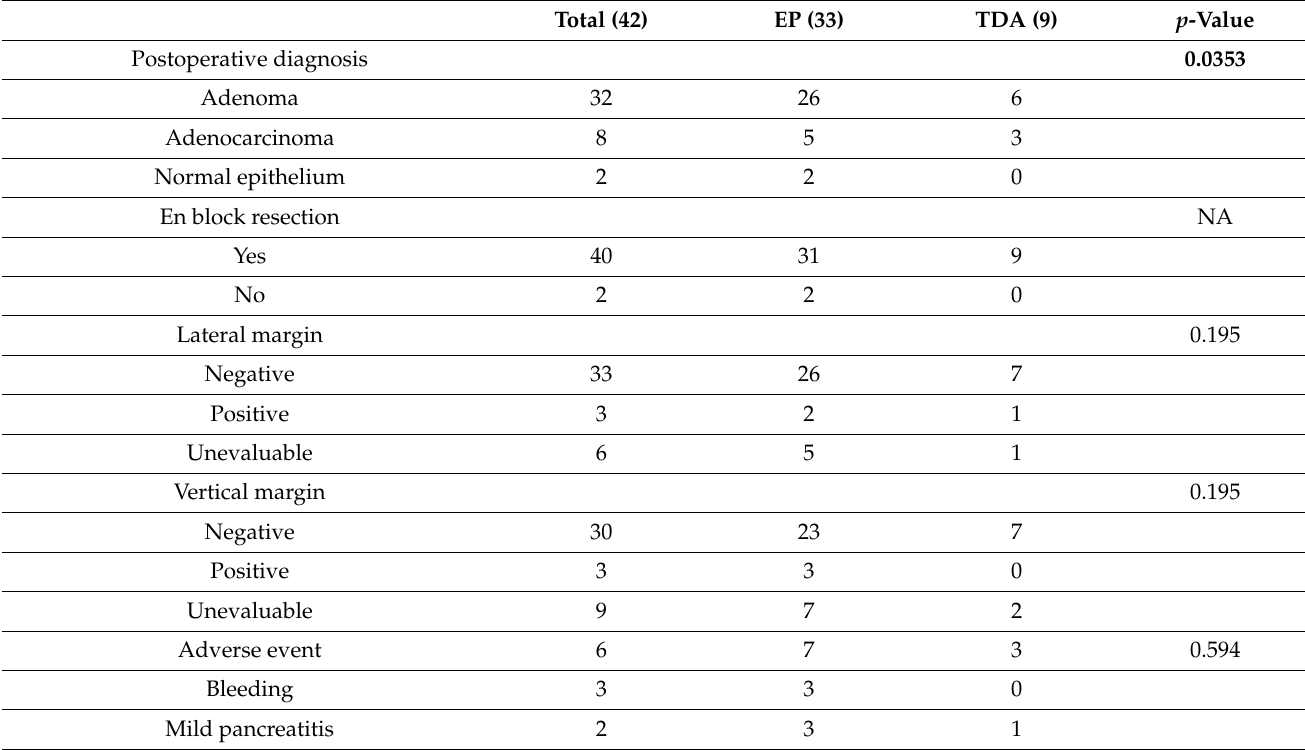
Table 2. Post-treatment